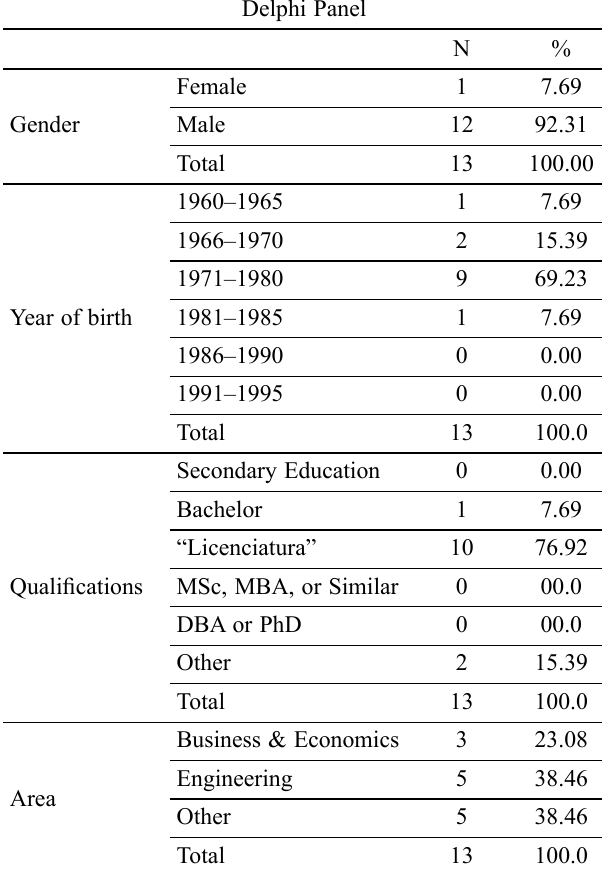
Table 1. Characterization of the respondents (second round) Delphi Panel N % Female 1 7.69 Gender Male 12 92.31 13